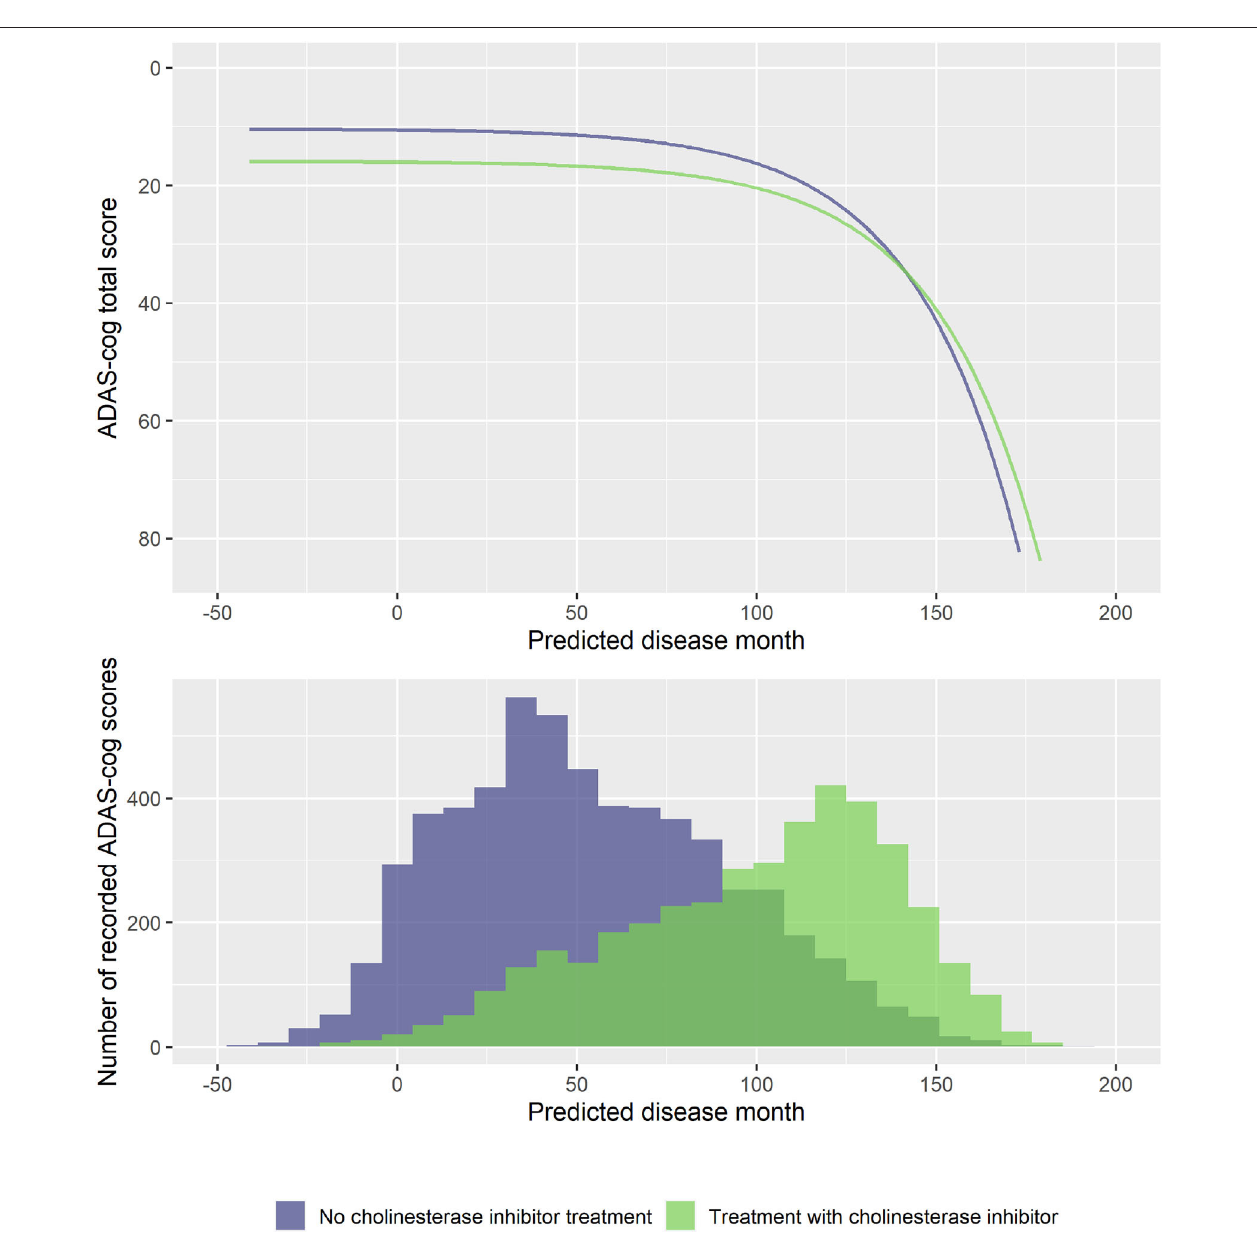
FIGURE 8 | Estimated trajectories for patients with and without cholinesterase inhibitor treatment (top) and corresponding distribution of number of observed ADAS-Cog scores at corresponding predicted disease times. The trajectories are aligned at predicted month 0 that corresponds to the average cognitive stage of cognitively normal individuals that are not treated with cholinesterase inhibitors at